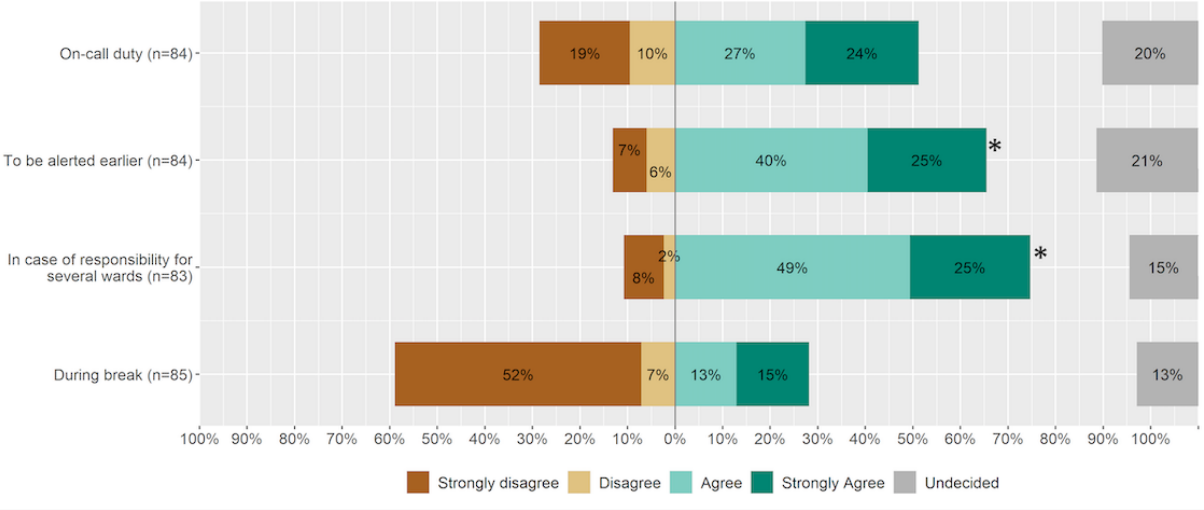
Figure 6. Use cases for clinical decision support systems based on artificial intelligence in the ICU. An asterisk indicates statistical significance. ICU: intensive care unit.